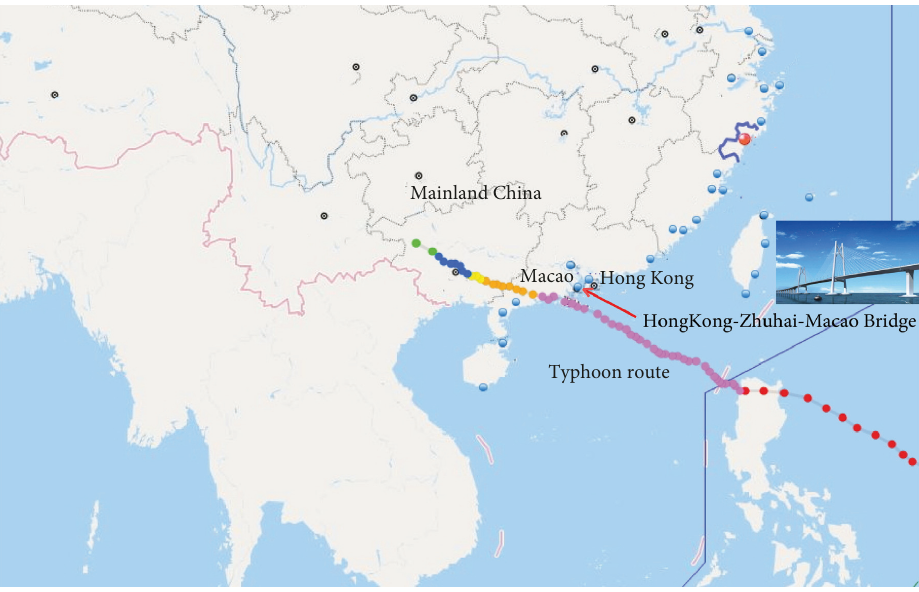
Figure 10: Typhoon Mangkhut’s